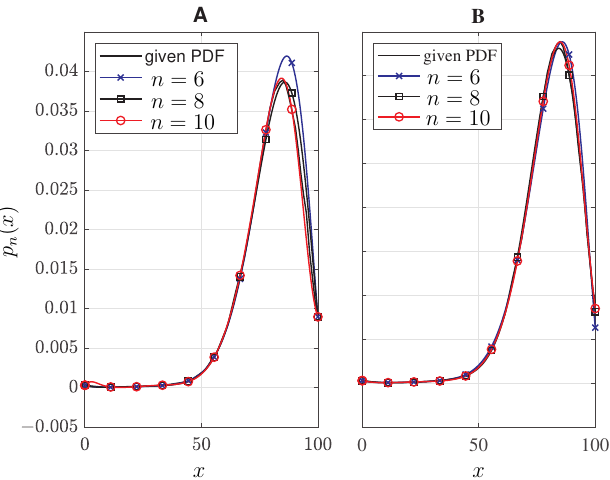
Figure 8. The approximations of a given PDF by Lagrange polynomials assuming N = 6,8, and 10 equidistant samples ( A ), and the same number of Chebyshev samples ( B